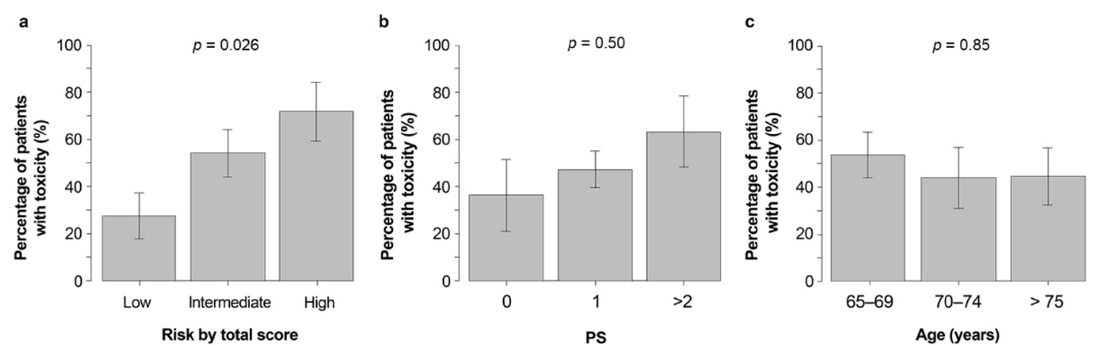
Figure 1. Grade 3–5 CRAE incidence in those with low, medium and high ( a ) CARG risk scores, ( b ) PS, and ( c ) age classifications. Abbreviations: CARG, Cancer and Aging Research Group; PS, performance status; Gr3–5 CRAEs, grade 3–5 chemotherapy-related adverse events.